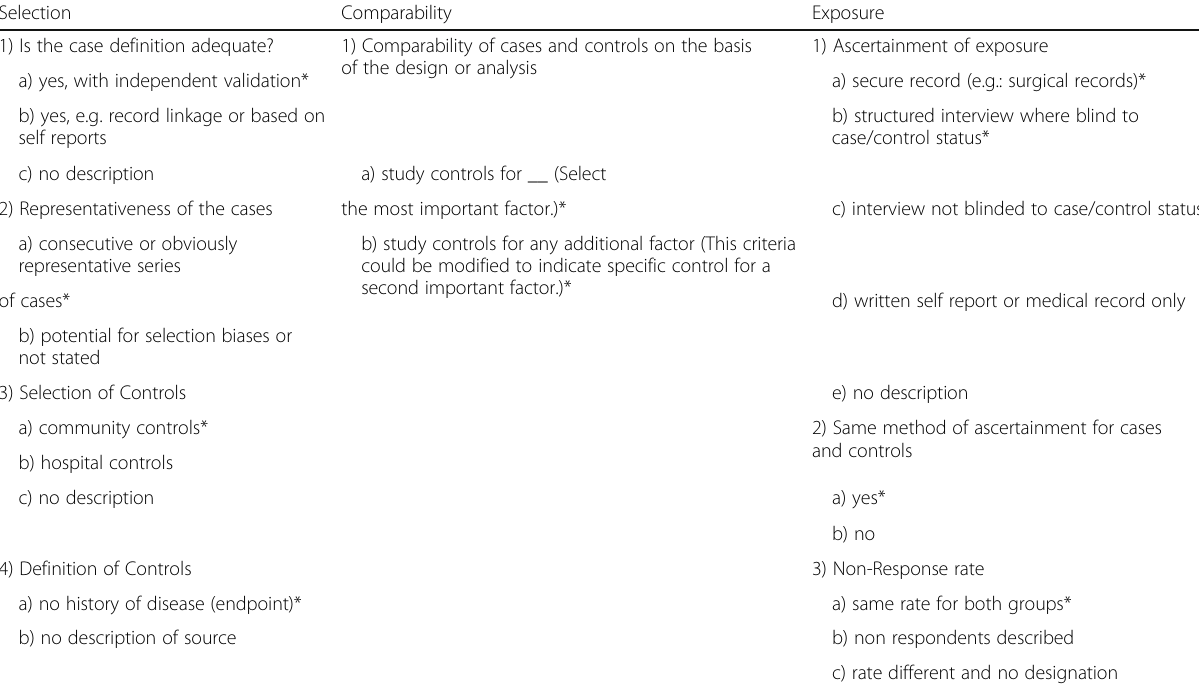
Table 1 The Newcastle-Ottawa Scale (NOS) for assessing the quality of case controlled studies in meta-analyses